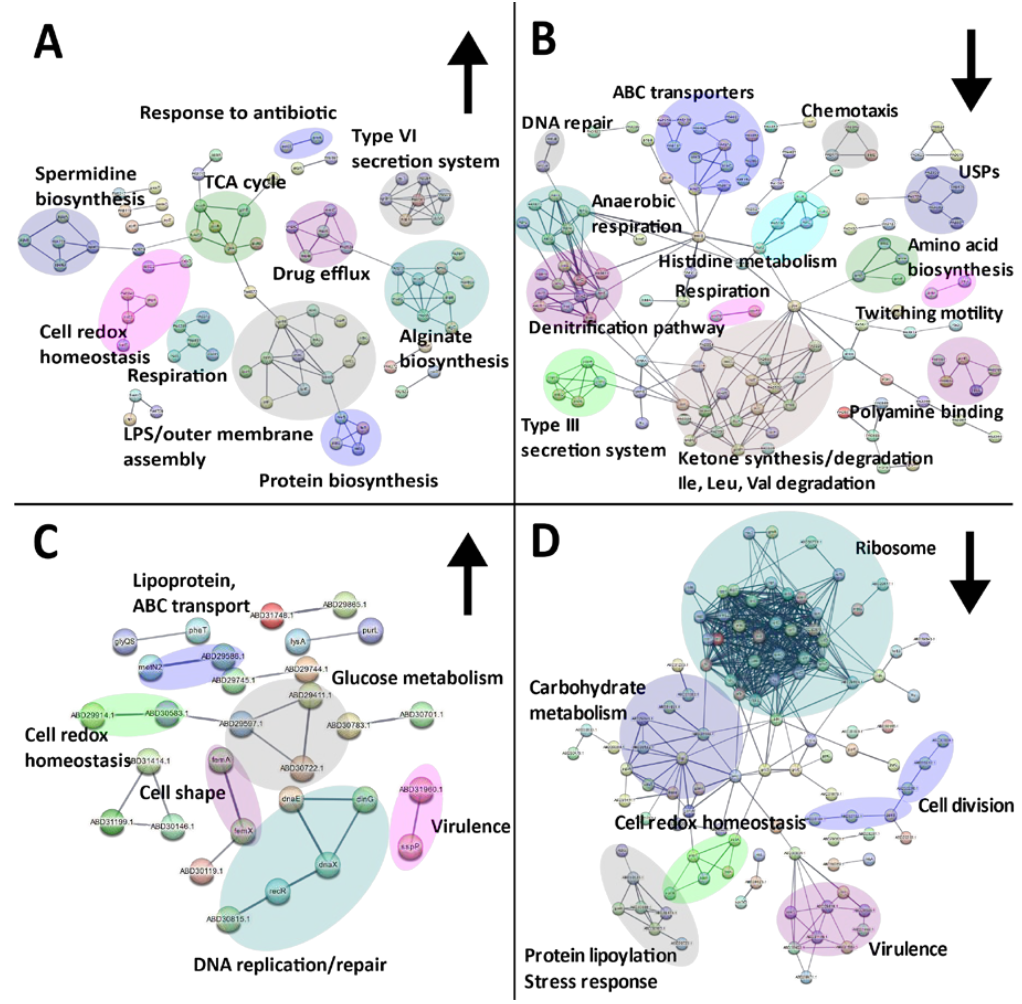
Figure 6. STRING network analyses of SSDA proteins derived from two-sample t -tests ( p < 0.05) showing the responses of P. aeruginosa ( A , B ) and S. aureus ( C , D ) to SBC3. Nodes represent individual proteins (annotated with the corresponding gene name or STRING identifier) and are connected to represent an interaction. The thickness of the line represents the strength of data support. Interaction networks with proteins increased in abundance are displayed on the left ( A , C ) indicated by upward arrows and those decreased are shown on the right ( B , D ) indicated by downward arrows. Protein genes/IDs were searched via the UniProt database in addition to functional enrichment analysis on STRING to determine KEGG and Gene Ontology (GO) terms.